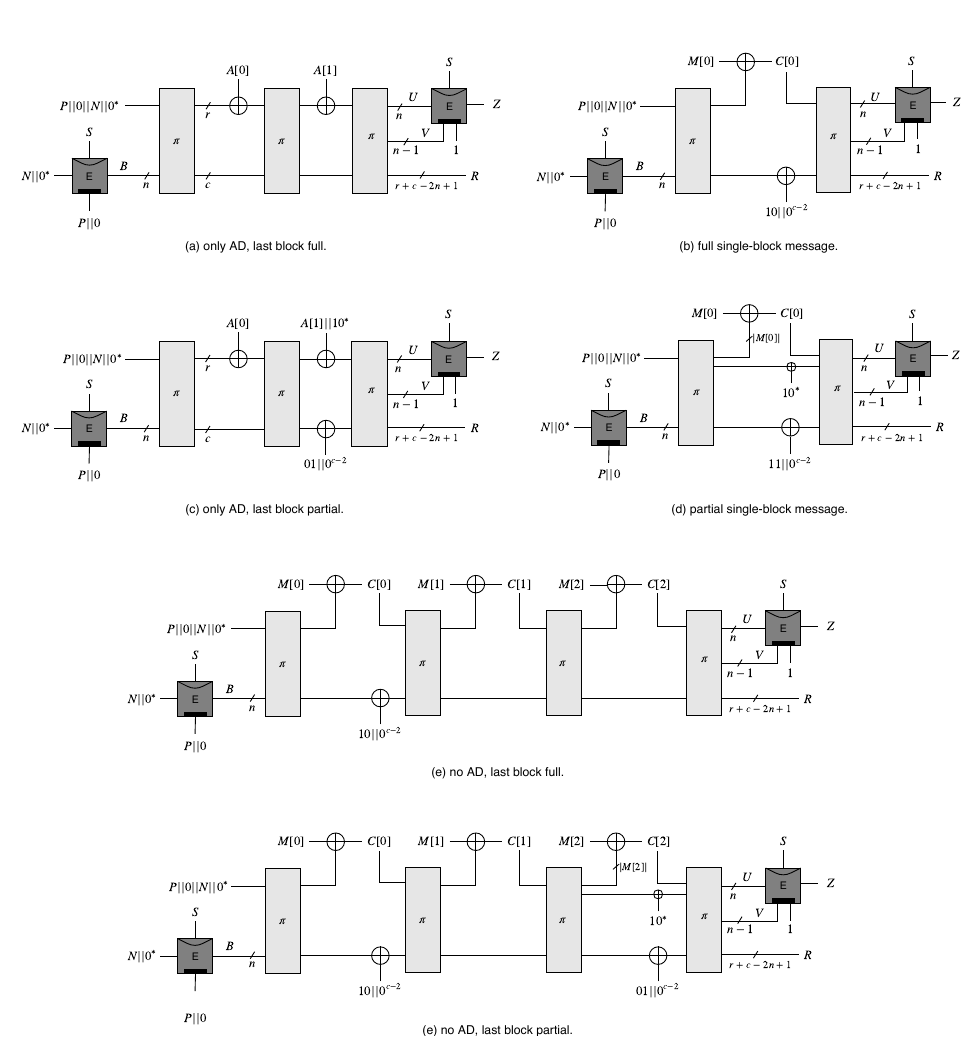
Figure 3: Different cases of the TETSponge mode of